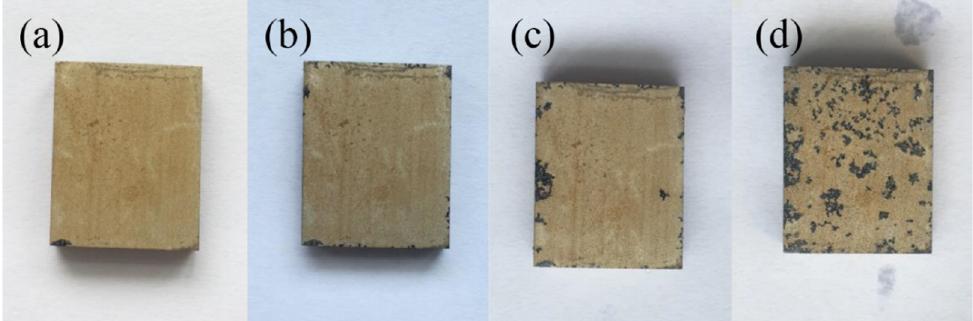
Figure 6. Macromorphologies of 12 h sample immersed in SBF solution: ( a ) 24 h; ( b ) 72 h; ( c ) 120 h; ( d ) 168 h.